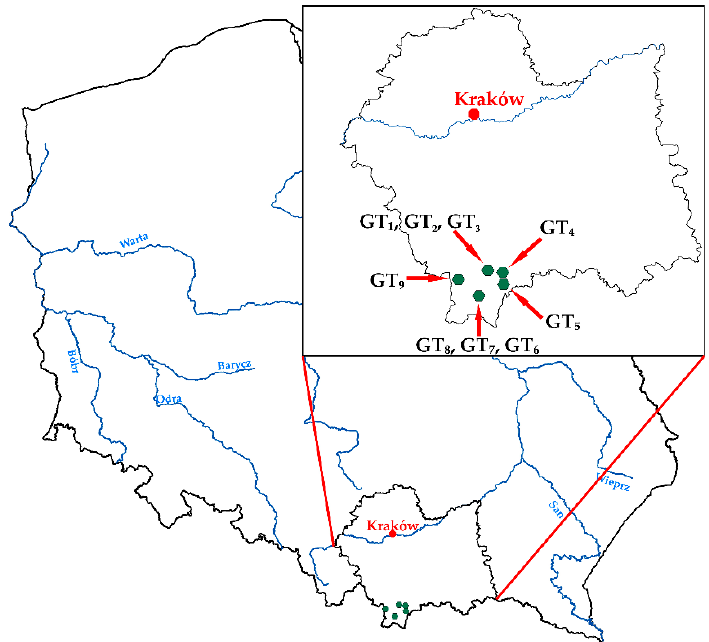
Figure 1. Map of geothermal water well locations.